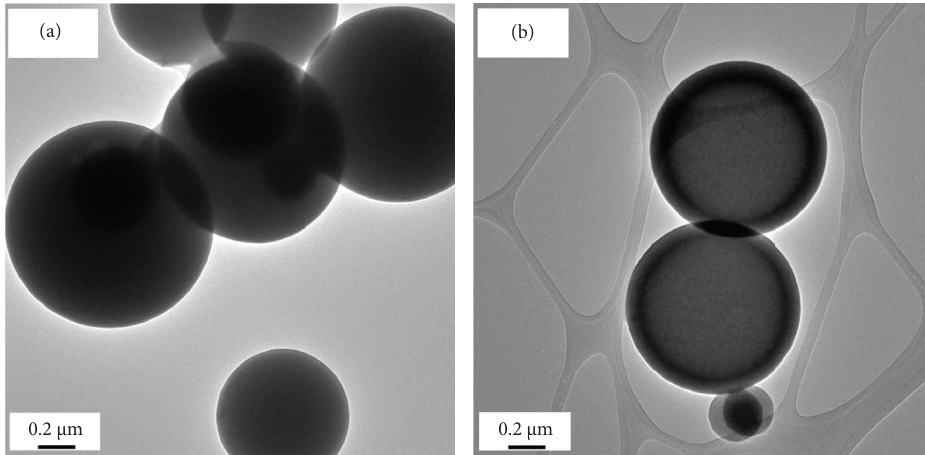
Figure 4: TEM images of (a) solid BG particles and (b) hollow PEG derived-BG